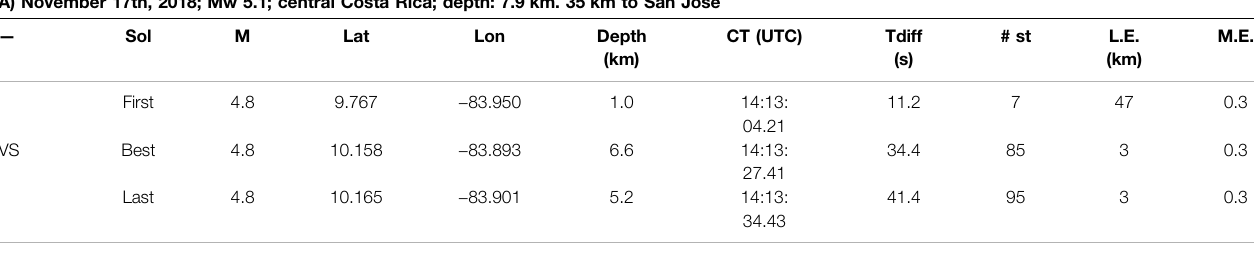
TABLE 3 | Solutions of VS and FinDer for the other four earthquakes in different regions of Costa Rica. Sol (cid:1) solution, M (cid:1) magnitude, Lat (cid:1) latitude, Lon (cid:1) longitude, CT (cid:1) creation time, Tdiff (s) (cid:1) time difference in seconds between CT and OT, #st (cid:1) number of stations used in the VS solution, L.E. (km) (cid:1) location error, and M.E. (cid:1) absolute value of magnitude error. The best solutions are chosen when the smallest location differences are obtained compared to the RSN